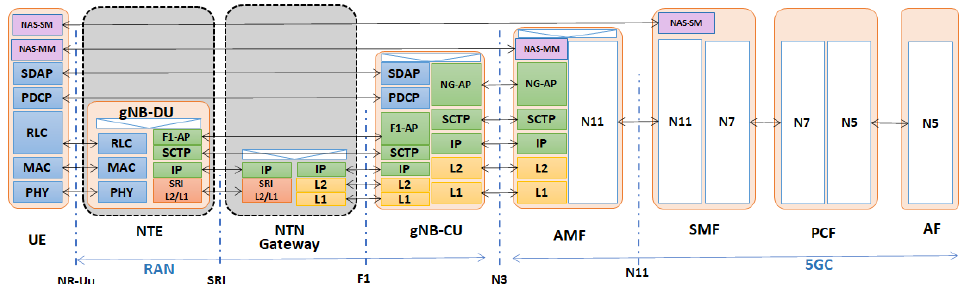
Figure 10. Protocol stack of the control plane in the NTN architecture with on-board distributed unit